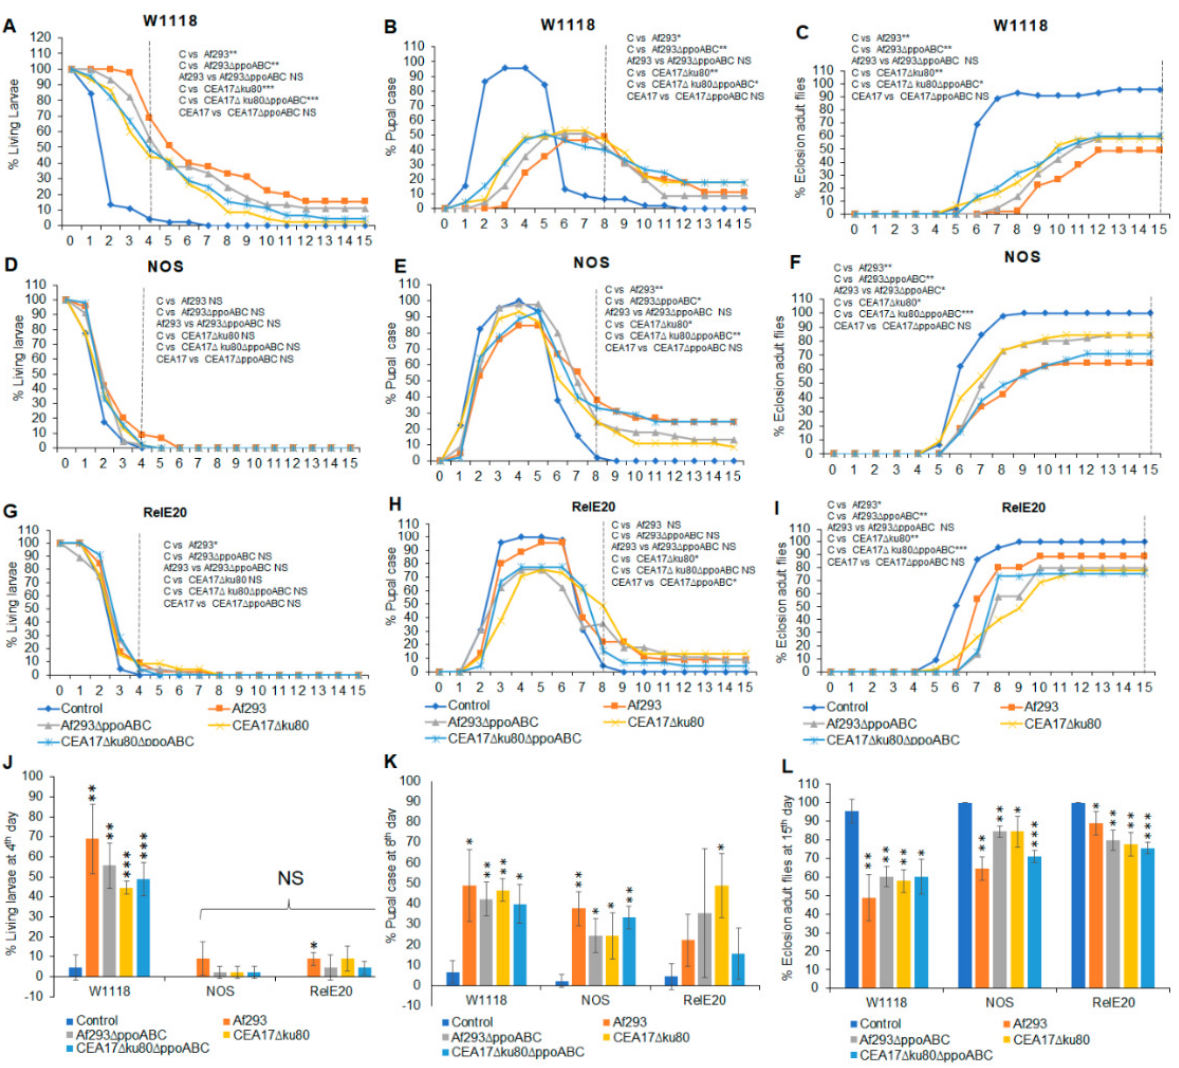
Figure 1. Effects of VOCs emitted from four different A . fumigatus strains pre − grown on PDA at 25 ◦ C for 5 days on the third instar white − eyed fly larvae over 15 days of continuous exposure. The percentages of living larvae, pupal case, and eclosion adult flies are as follows: w 1118 living larvae ( A ), NOS larvae ( D ), and Rel E20 larvae ( G ); w 1118 pupal case ( B ), NOS pupal case ( E ), and Rel E20 pupal case ( H ); and w 1118 eclosion adult flies ( C ), NOS eclosion adult flies ( F ), and Rel E20 eclosion adult flies ( I ). The statistical analyses were performed for the living larvae on the 4th day ( J ), the pupal case on the 8th day ( K ), and the eclosion adult flies on the 15th day ( L ). A dashed vertical line denotes the days for statistical analysis (N = 180). * Represents the significant differences between different treatments, where 0.005 < * p < 0.05, 0.0005 < ** p < 0.005, *** p < 0.0005; NS, p > 0.05.